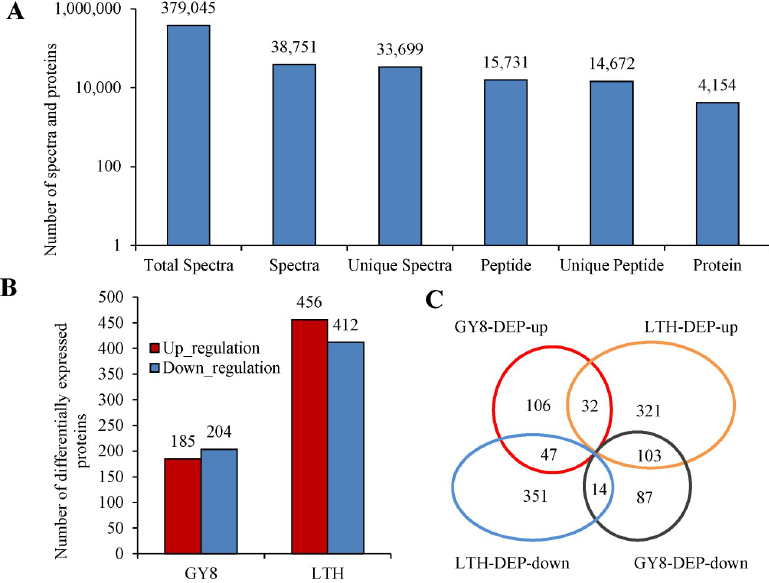
Fig 2. Distribution of differentially expressed proteins (DEPs) between the resistant (GY8) and susceptible (LTH) variety following inoculation with M . oryzae . A: Results of the mass spectrometry analysis and protein identification. B: Number of up-regulated and down-regulated proteins. C: Venn diagram analysis the DEPs that were up- or down- regulated in GY8 and LTH.